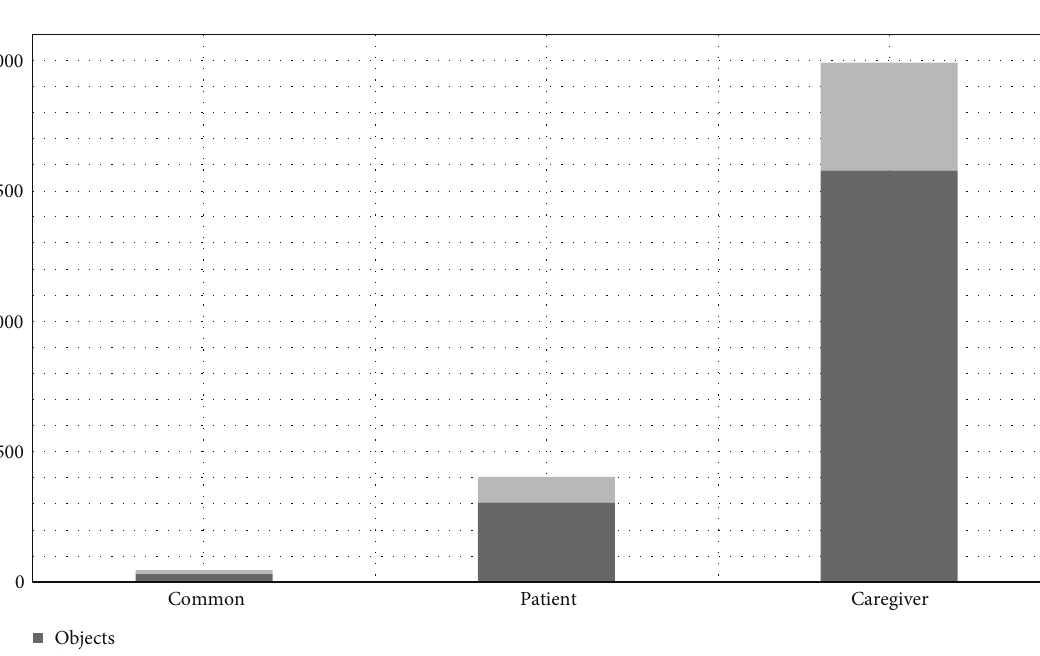
Figure 8: Distribution of the interface objects and actions for each user